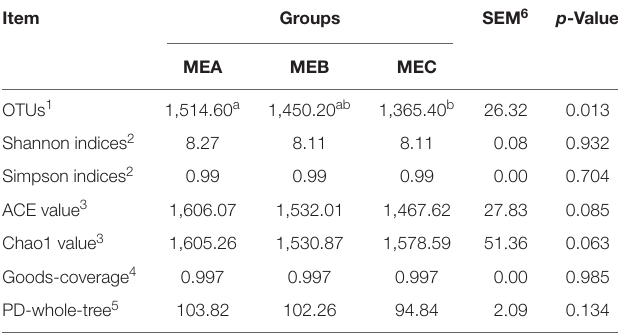
TABLE 4 | Rumen microbiota diversity indices of different dietary energy